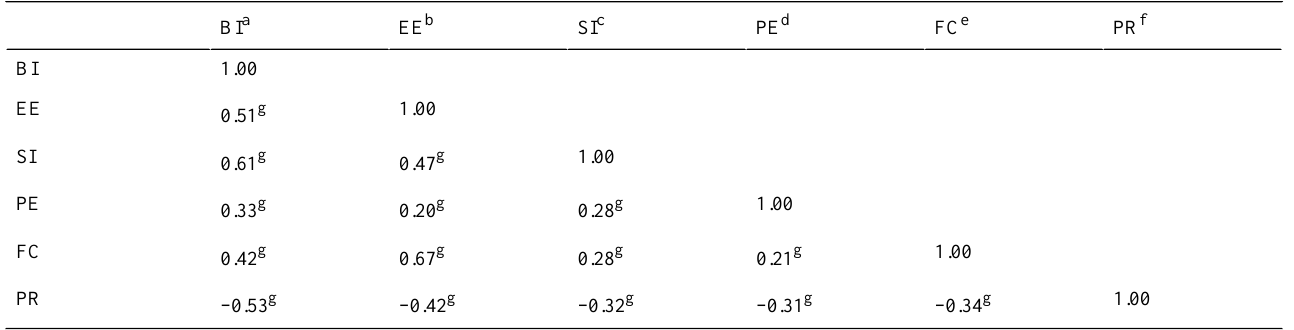
Table 7. Pearson correlation coefficients among dependent variables.